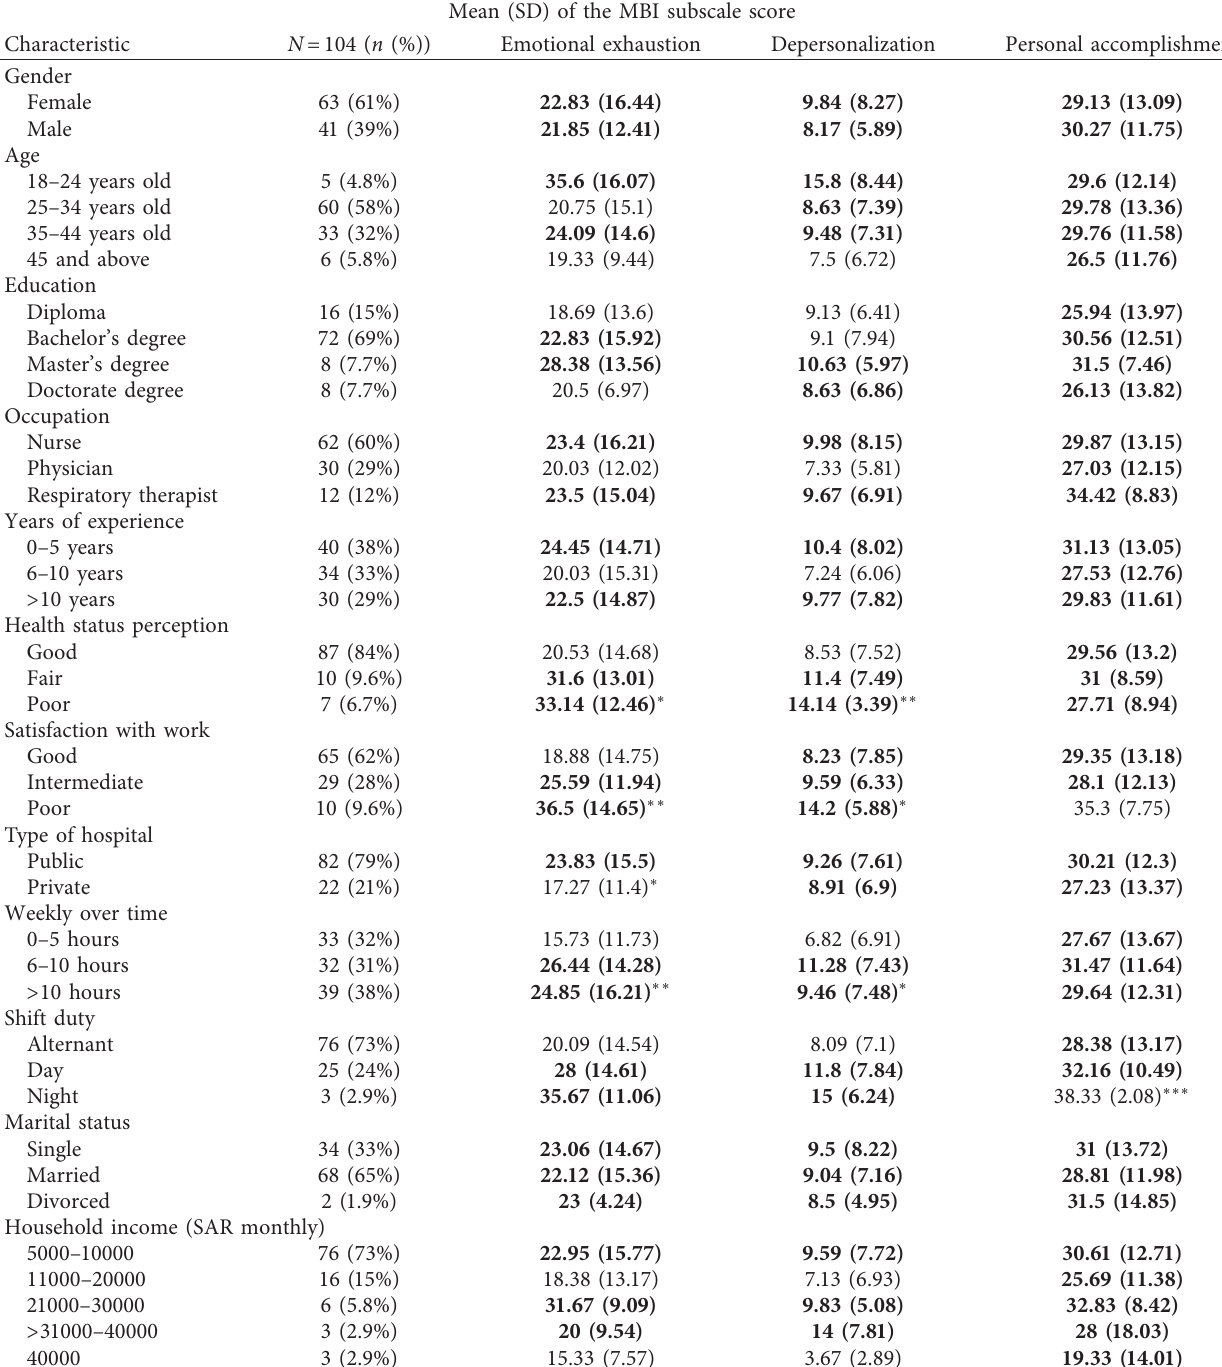
Table 1: Participant characteristics and mean (SD) of the MBI subscale scores of ICU staff according to sociodemographic, environmental, and work